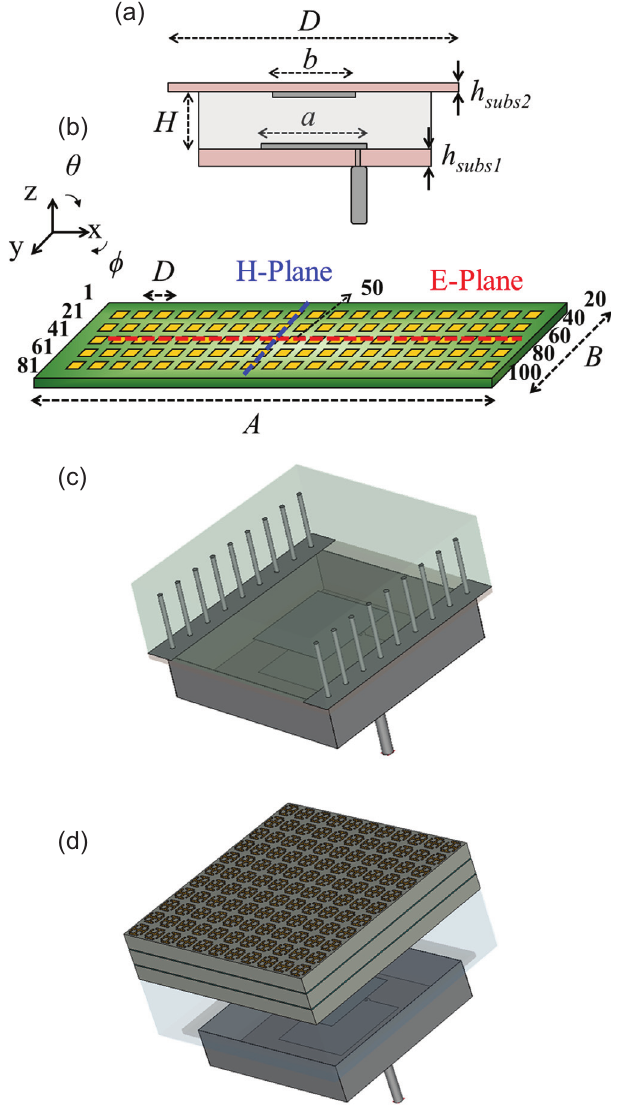
Figure 1. Schematics showing the original antenna element and the solutions developed. (a) Unit cell cross section with parameters. (b) 5 · 20 array schematic with E- and H-planes outlined. Numbers at right and left of the array denote the element number in the array (e.g. 50 is the central element). Dimensions: A = 400 mm, B = 115 mm, D = 19 mm, a = 7.8 mm and b = 7.5 mm, h subs1 = 0.81 mm and h subs2 = 0.51 mm. (c) Schematic unit cell of wire medium-based metaradome. (d) Schematic unit cell of Jerusalem cross-based metaradome.